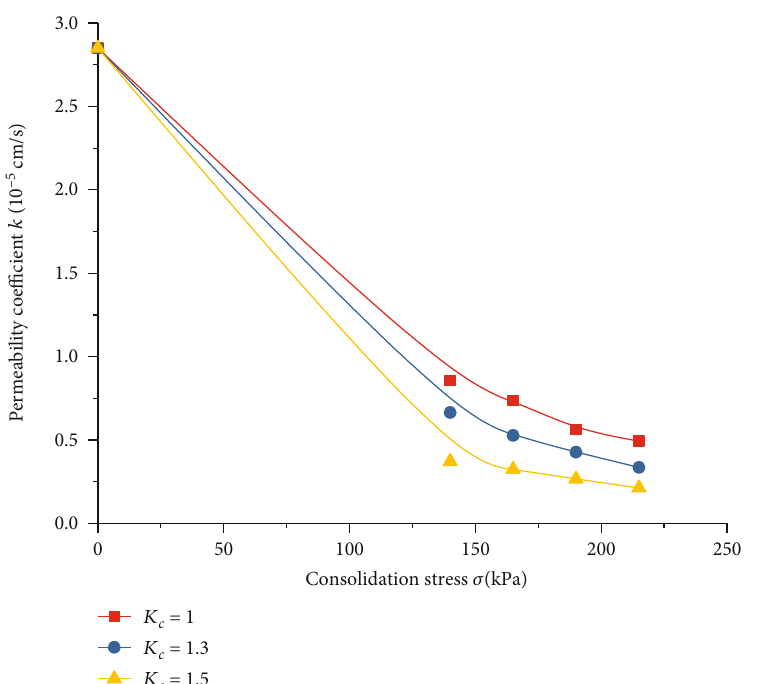
Figure 5: The curve of permeability coe ffi cient of normally consolidation clay with consolidation pressure at di ff erent consolidation stress ratios.